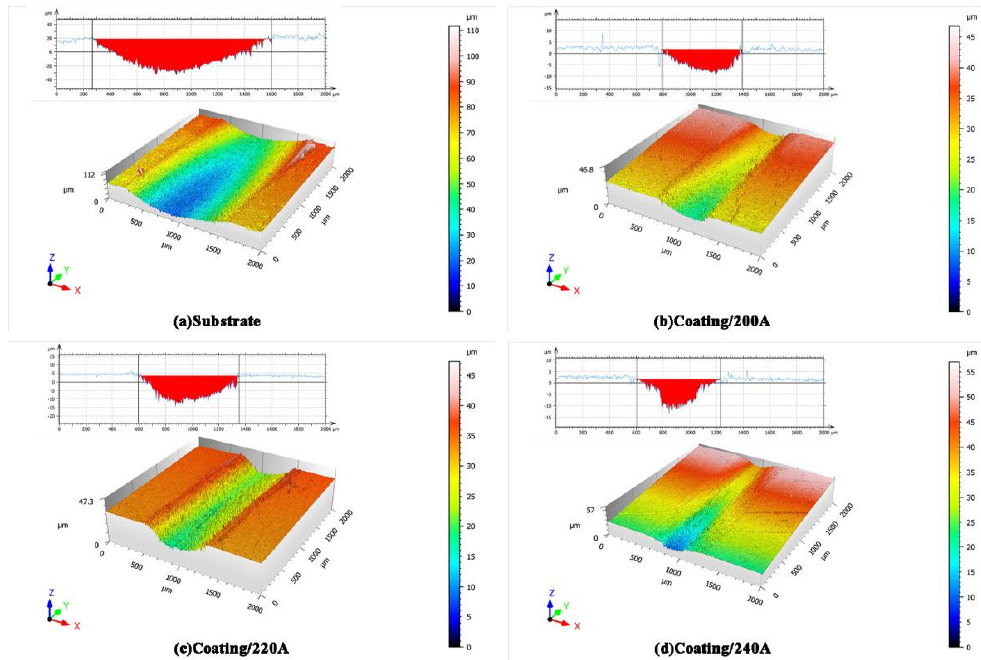
Figure 6. ( a ) 3D view and cross-sectional view of the abrasion marks of the base material. ( b – d ) 3D view and cross-sectional view of the abrasion marks of the FeCrMnCuNiSi 1 high-entropy alloy coating with different melting currents.